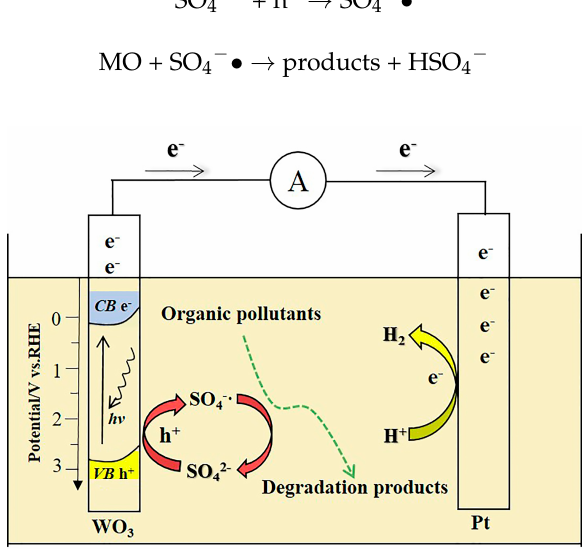
Figure 6. Schematic illustration of efficiently degrading MO with WO 3 electrode in Na 2 SO 4 .